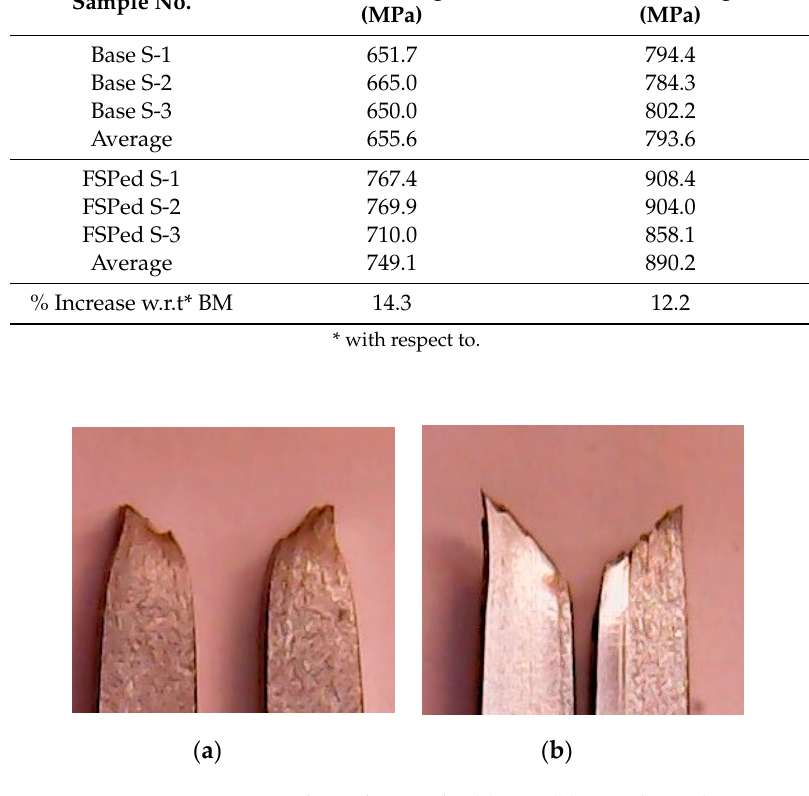
Figure 12. Fractured tensile sample: ( a ) BM, ( b ) FSPed metal. Table 3. Tensile behavior of BM and FSPed 2507 SDSS.